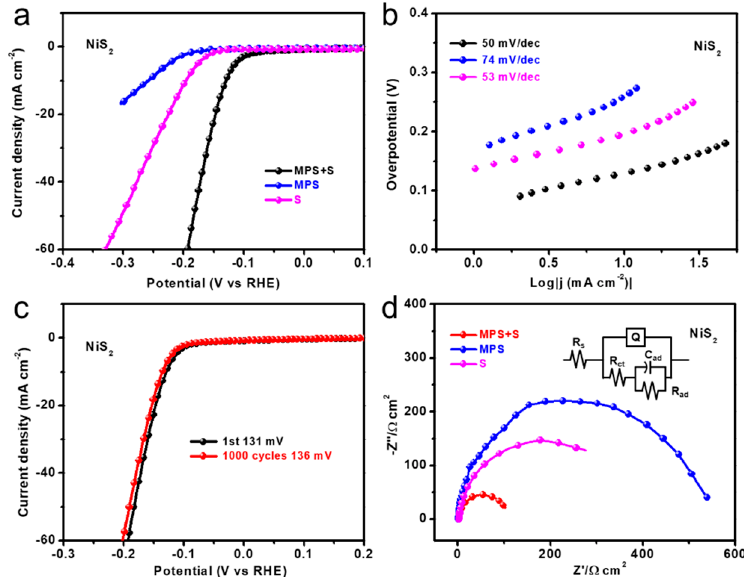
Figure 3. ( a ) LSV curves of NiS 2 fabricated from different sulfur sources. ( b ) The corresponding Tafel plots of samples; ( c ) LSV curves before and after 1000 CV cycles and ( d ) electrochemical impedance spectroscopy of samples.